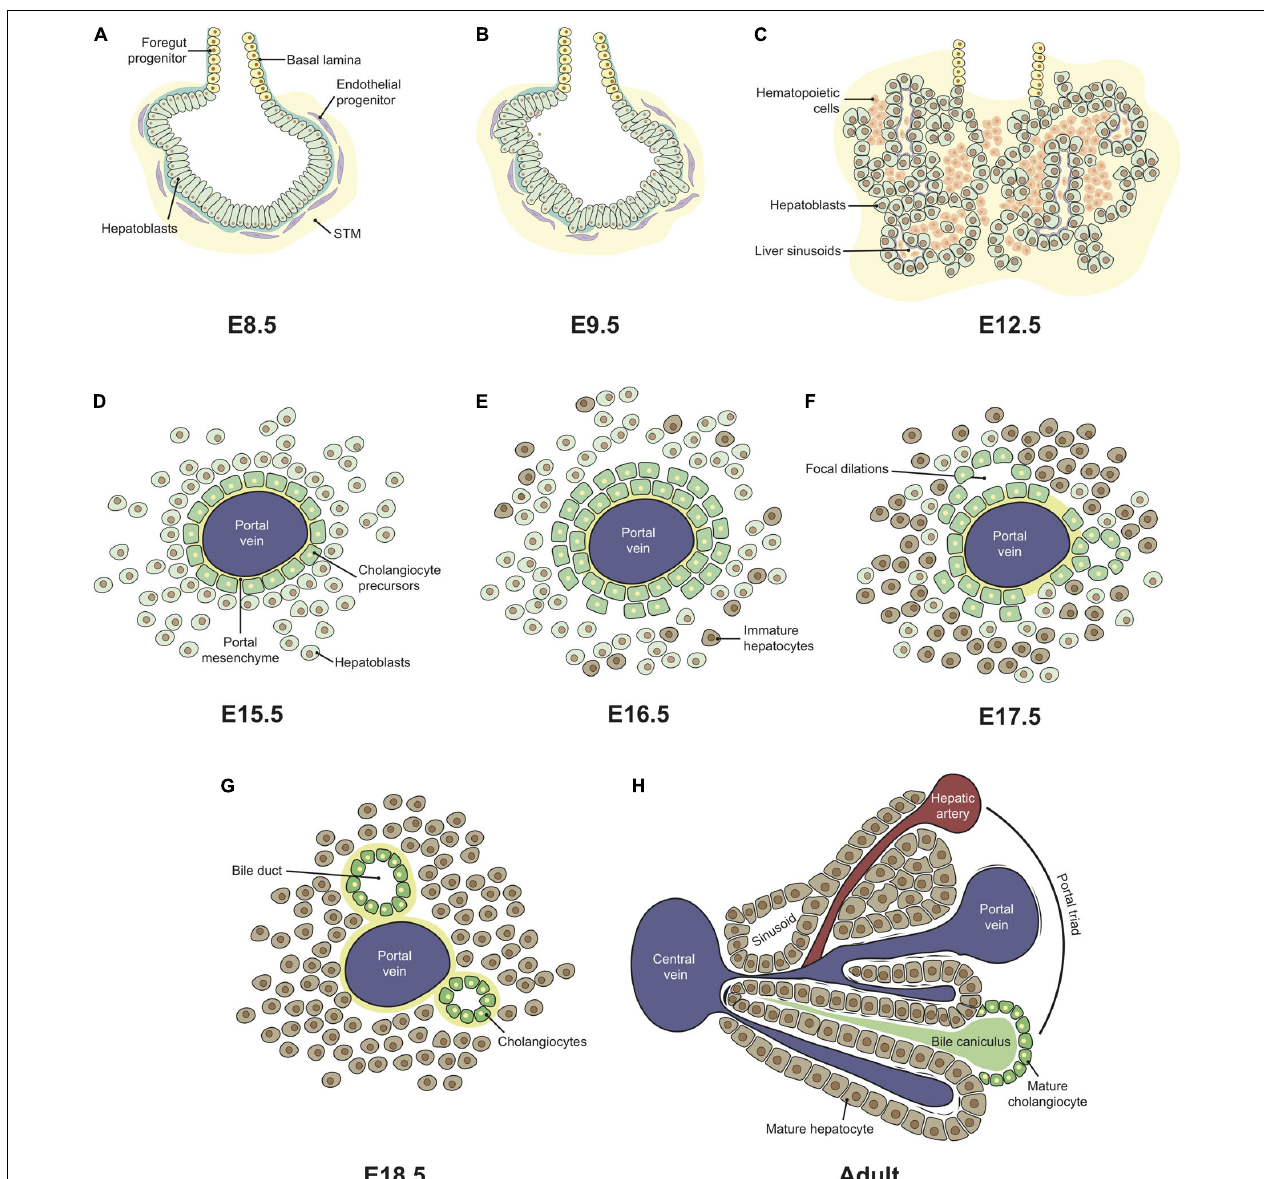
FIGURE 2 | Ontogeny of the fetal liver. Liver development is initiated with the formation of the hepatic diverticulum at E8.5 (A) . The single layer of columnar endodermal epithelial cells (A) thickens and transitions to a pseudostratified epithelium, followed by the delamination and migration of hepatoblasts into the STM, forming the liver bud by E9.5 (B) . Extensive hepatoblast proliferation follows, originating hepatic chords intermingled with the hepatic mesenchyme and surrounding the sinusoids, formed from pre-existing vitelline vessels. From E10.5, hematopoietic cells colonize the FL that rapidly becomes the major fetal hematopoietic organ up until E15.5 (C) . From E12.5-E15.5, the FL continues to enlarge, expanding both hematopoietic and hepatic compartments. Structural changes are only evident after hepatoblast-to-cholangiocyte specification occurs around the portal vessels, forming a monolayered ductal plate (D) that evolves into a bi-layer at E16.5 (E) . Focal dilations (F) evolve into bile duct structures in late gestation (G) . Portal triads characterize adult liver architecture where a hepatic artery, a portal vein and a bile duct form a complex structure, and a central vein, to which plates of hepatocytes lined by sinusoids converge (H) . This architecture is only recognizable few